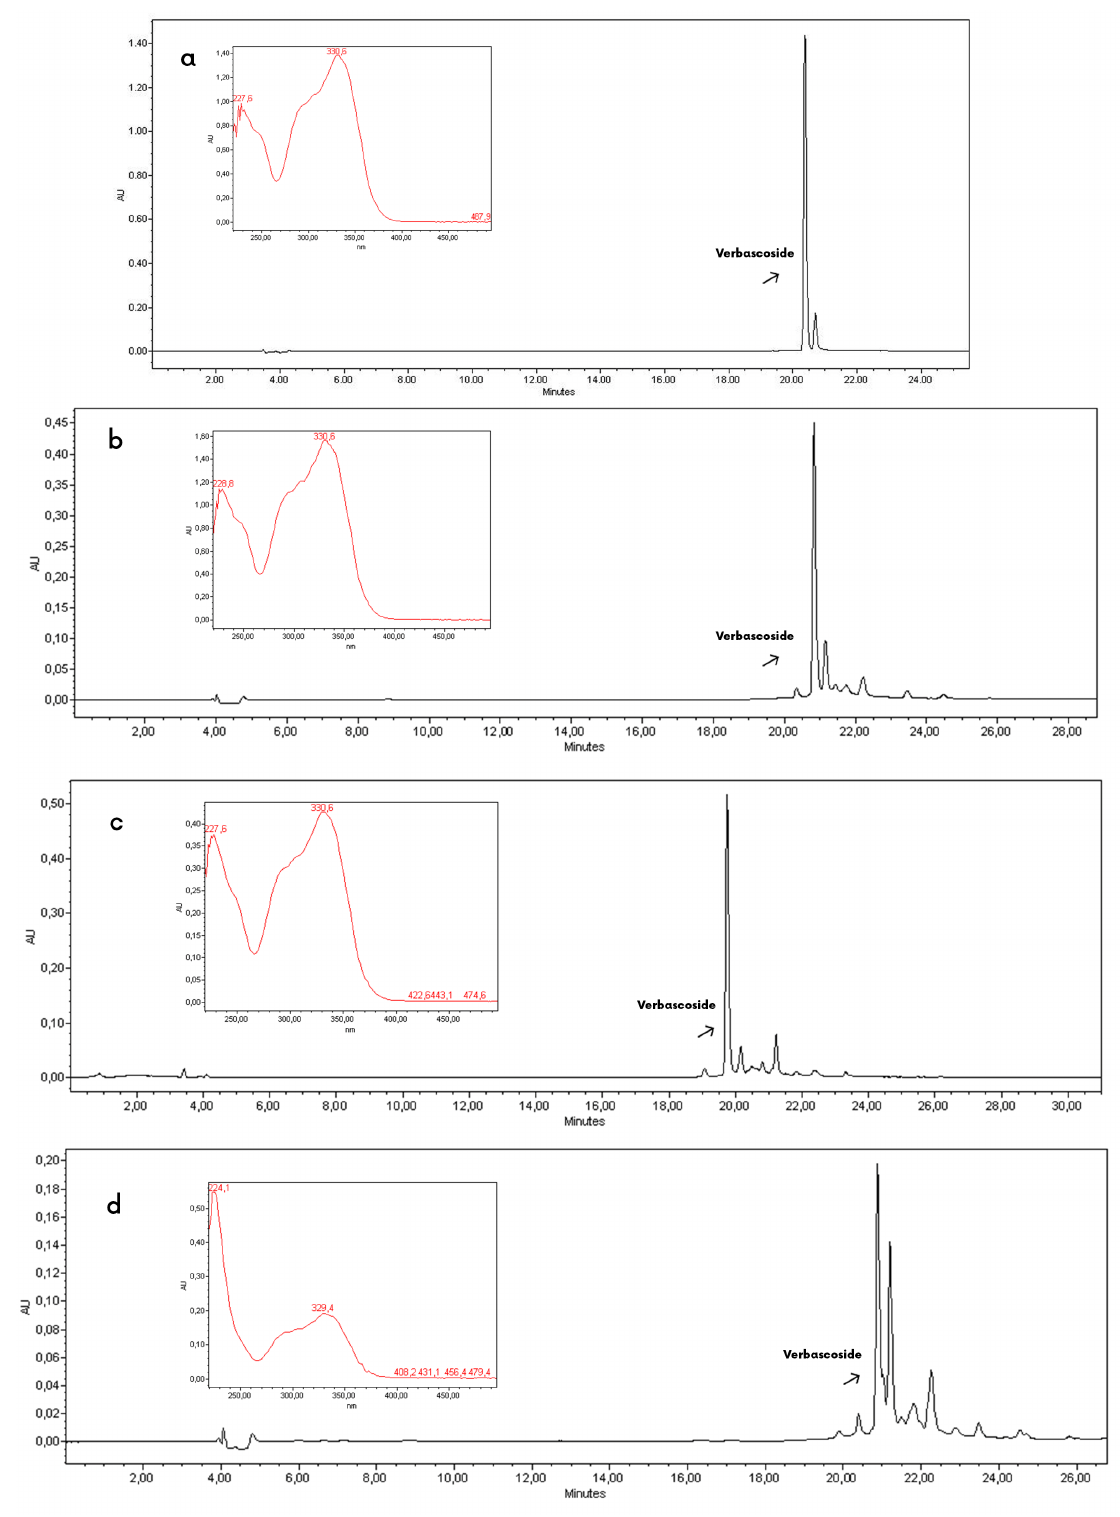
Figure 2. Chromatograms at 330 nm and UV-DAD spectra for peak at 20.1 minutes: (a) Verbascoside standard at 500.0 μg mL -1 and Extracts of (b) Leaves 2010 (c) Flowers 2011 (d) Stems 2012 of Verbena